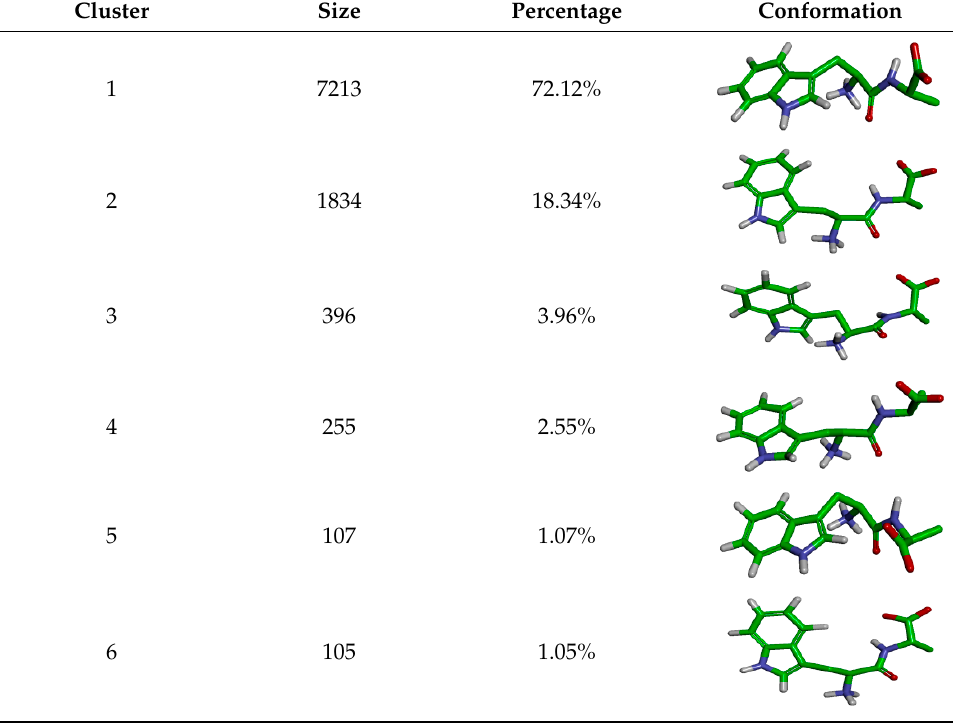
Table 2. The cluster size and the representative conformations of WA collected in the first six clusters. Cluster